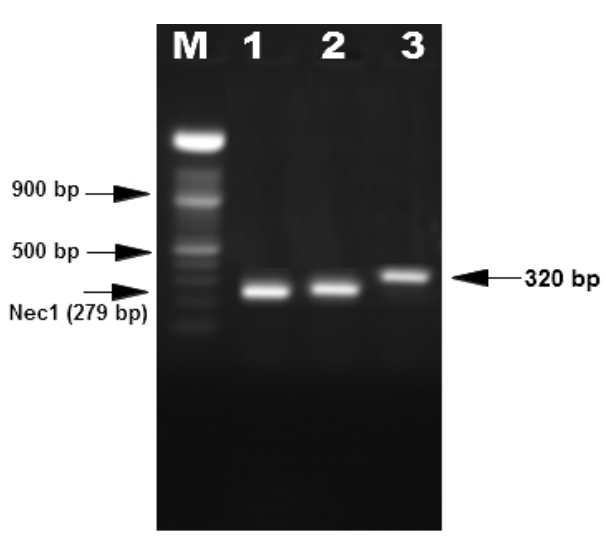
Fig. 1. Detection of nec1 gene in Streptomyces scabies isolates